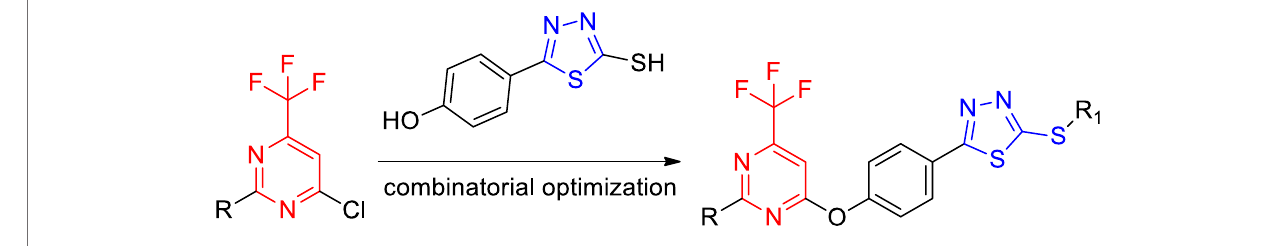
FIGURE 1 | Design of the target